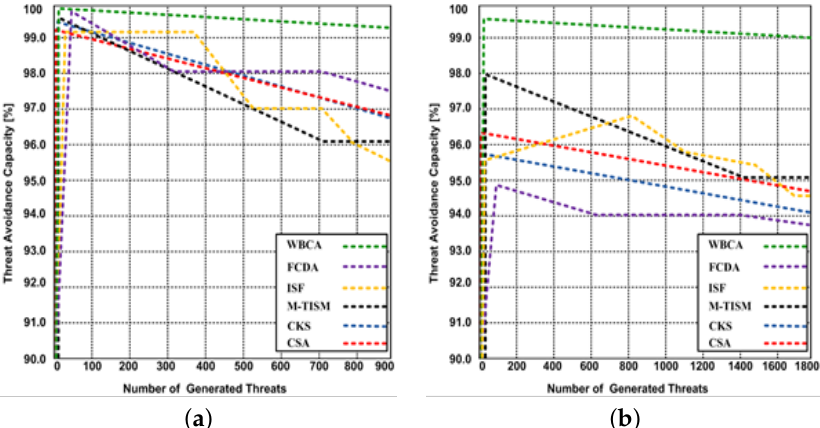
Figure 6. ( a ) Threat avoidance capacity of the proposed WBCA and contending programs (M-TISM, ISF, FDCA, CSA, and CKS) with maximum 900 threats. ( b ) Threat avoidance capacity of the proposed WBCA and contending programs (M-TISM, ISF, FDCA, CSA, and CKS) with maximum 1800